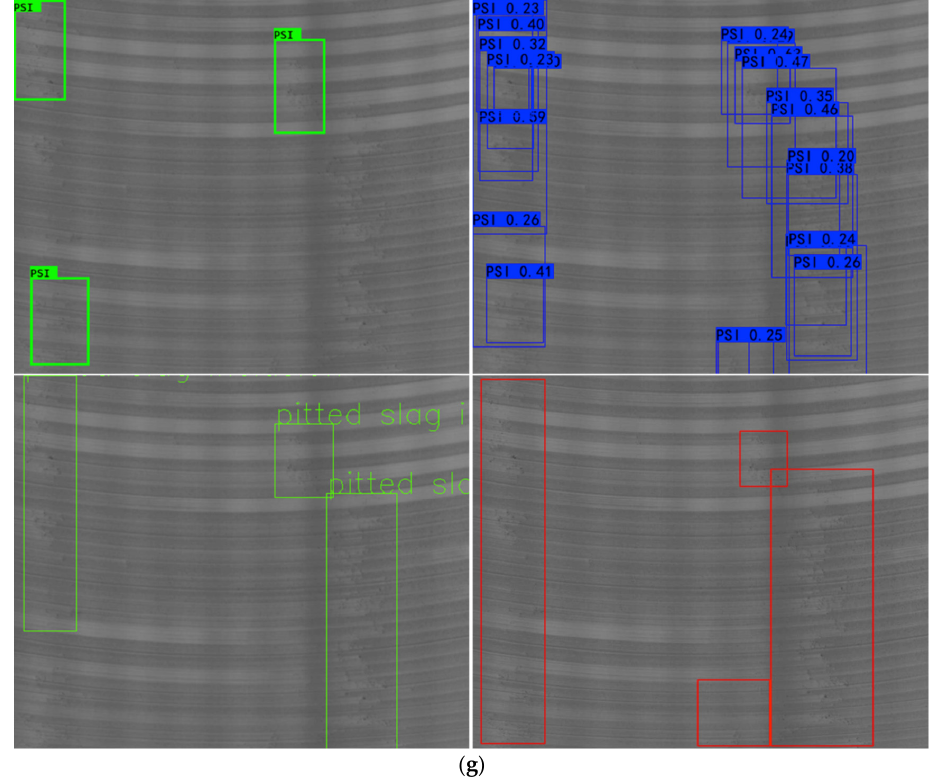
Figure 18. Detection effect of different methods: ( a ) PSI; ( b ) Sc; ( c ) SI; ( d ) OF; ( e ) Cr; ( f ) Cr; ( g ) PSI. The detection results of YOLOv3, RetinaNet, YOLOv4, and our method are shown from left to right in each group of comparison images. Table 4. Performance comparison of the four methods for each type of